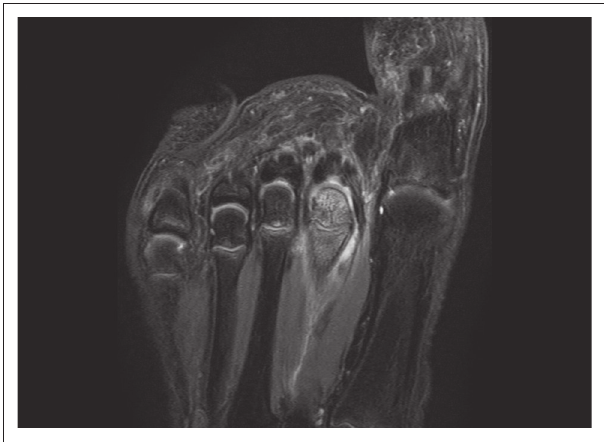
FIGURE 8: Long axis T2 FS MR image of the foot demonstrating oedema in the 2nd metatarsal head owing to Freiberg’s disease.